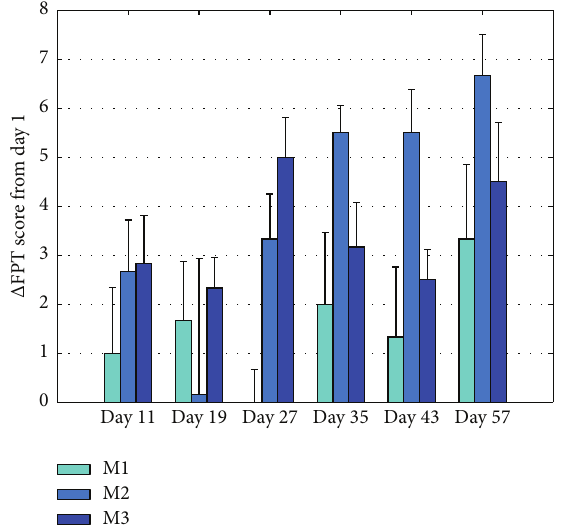
Figure 3: Forelimb placement test. Forelimb placement, reflecting sensorimotor deficit recovery, was tested in 15 animals at days 1, 11, 19, 27, 35, 43, and 57. M1 is a group receiving sham treatment, M2 was exposed to 3.93 Hz and M3 was exposed to 15.72 Hz VLIFE 2 min sessions, in alternate days, for a month and followed up for an additional month. Values are Mean ± SE of FPT difference from day 1. 𝑝 = 0.036 for M2 and 𝑝 = 0.04 for